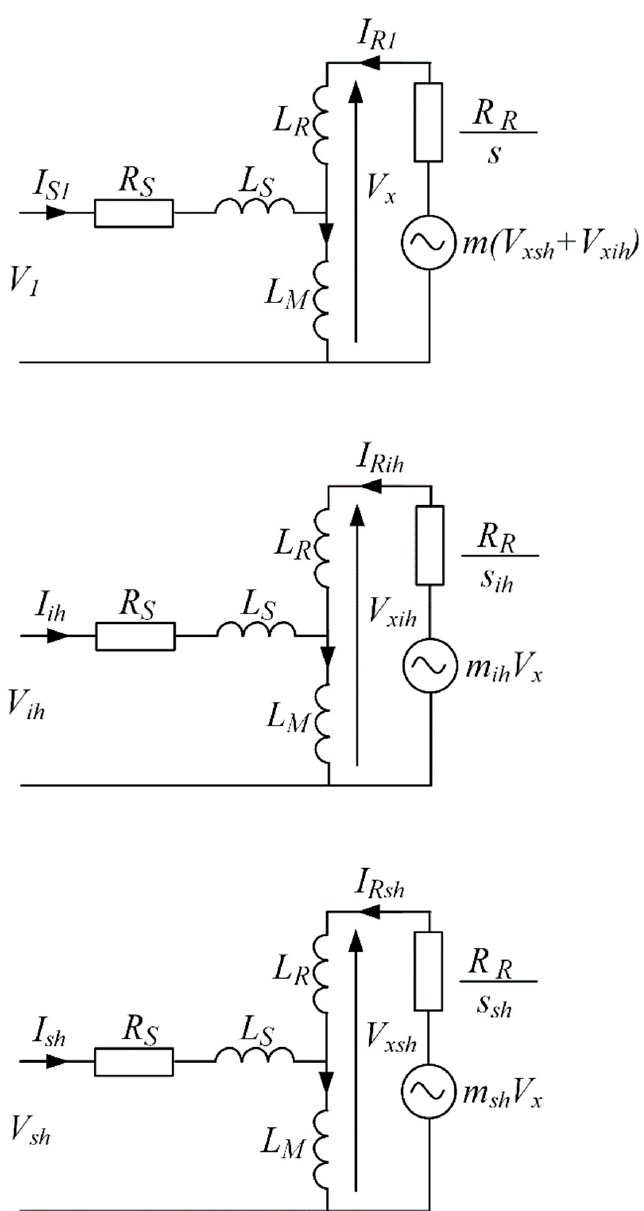
Figure 3. Dedicated equivalent circuit for the analysis of an induction motor under voltage fluctua- tions; s sh is a slip for the subharmonic component; s ih is the slip for the interharmonic component; V 1 , V sh and V ih are the fundamental, subharmonic and interharmonic voltage components; m , m ih , m sh are auxiliary variables depending on the amplitude of speed fluctuations, the modulation frequency, the fundamental frequency and the rotational speed.